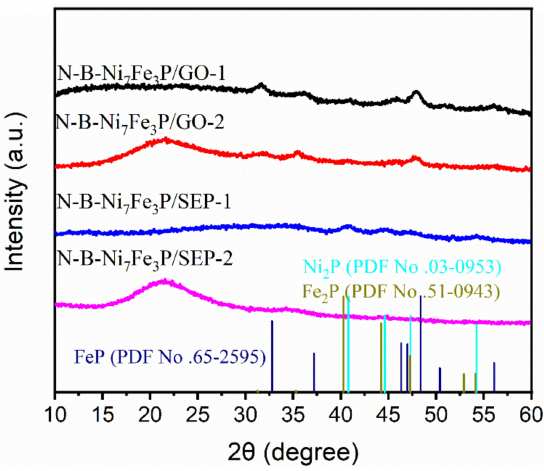
Figure 4. XRD pattern of the N-B-Ni 7 Fe 3 P/SEP and N-B-Ni 7 Fe 3 P/GO. The XPS survey scan spectrum (Figure 5I) confirmed that Ni, Fe, B, P, O, and C elements were present in the samples, conducting to character the chemical valence states of the composites. The Ni 2p1/2 and Ni 2p3/2 XPS (Figure 5II) of the N-B-Ni 7 Fe 3 P/SEP-1, N-B- Ni 7 Fe 3 P/GO-1, post-catalytic N-B-Ni 7 Fe 3 P/SEP-2 and N-B-Ni 7 Fe 3 P/GO-2 are observed at 874.5 and 856.4 eV, with additional intense satellite peaks characteristic of Ni 2+ (862.6 and 880.6 eV, respectively) [14]. A new peak arises at 853.7 eV in N-B-Ni 7 Fe 3 P/SEP-1, showing that the electronic structure has altered during the phase transition following